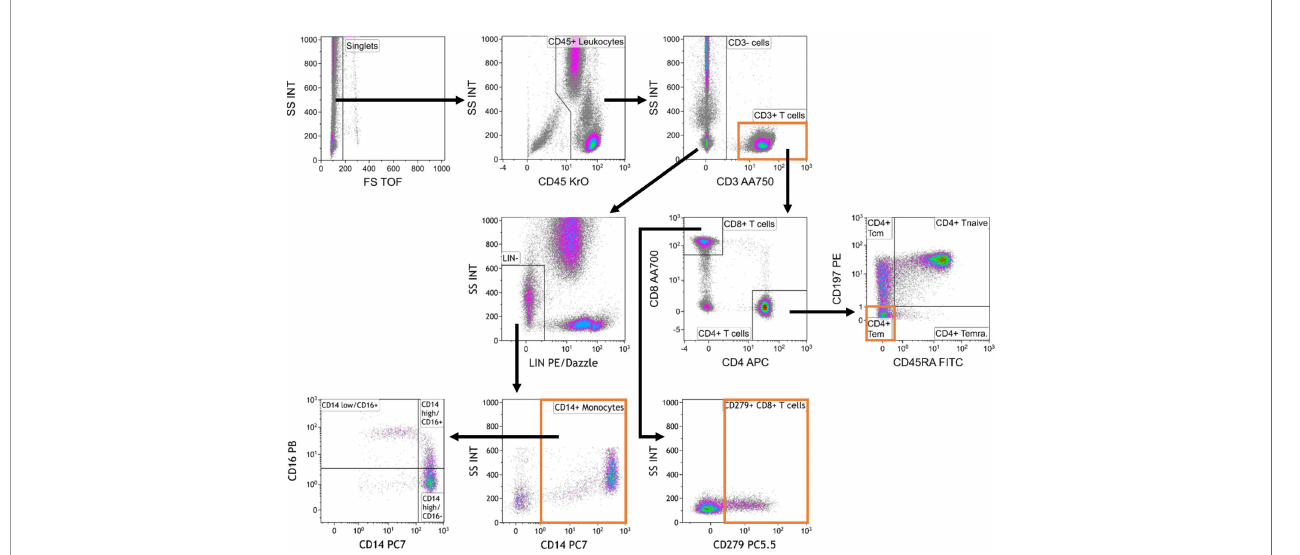
FIGURE 2 | Gating strategy used for analysis of the MoT test.. Data were analyzed as follows: Selection of singlets; gating on CD45 + leukocytes; gating on CD3 + T cells and CD3 - cells; gating on Lineage-negative (Lin - ) cells within the CD3 - compartment; gating on CD14 + monocytes; gating on monocyte subpopulations de fi ned by CD14 and CD16 expression; gating on CD4 + and CD8 + T cells within the CD3 + T cell compartment; gating on CD4 + memory T cell subsets; gating on CD279 + CD8 + T